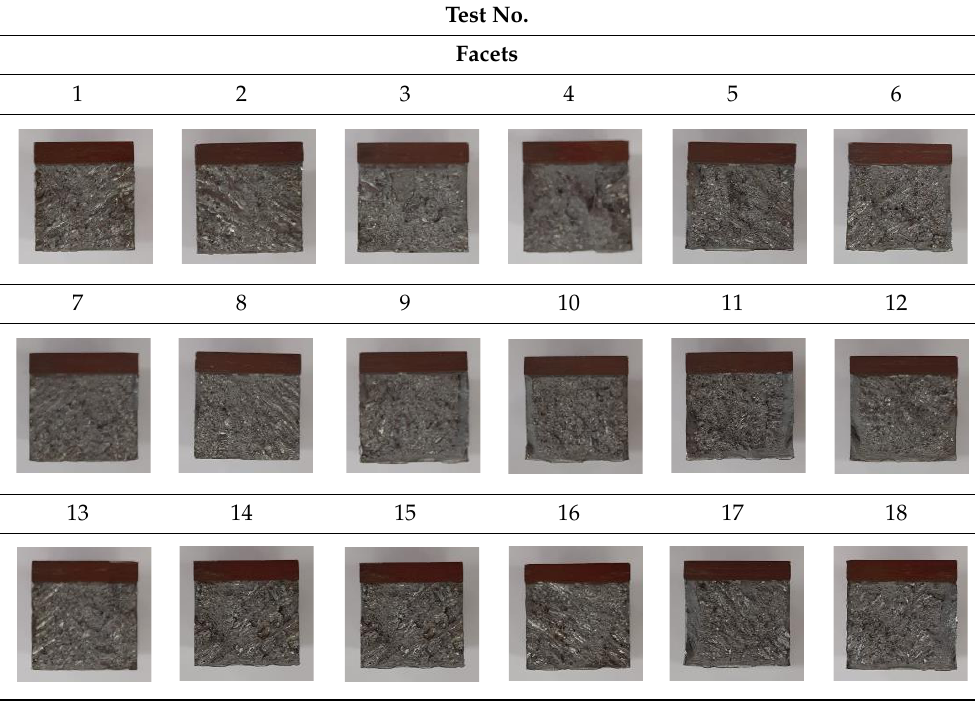
Table 6. Results of fracture geometry of the heat-affected zone according to the Charpy impact test.